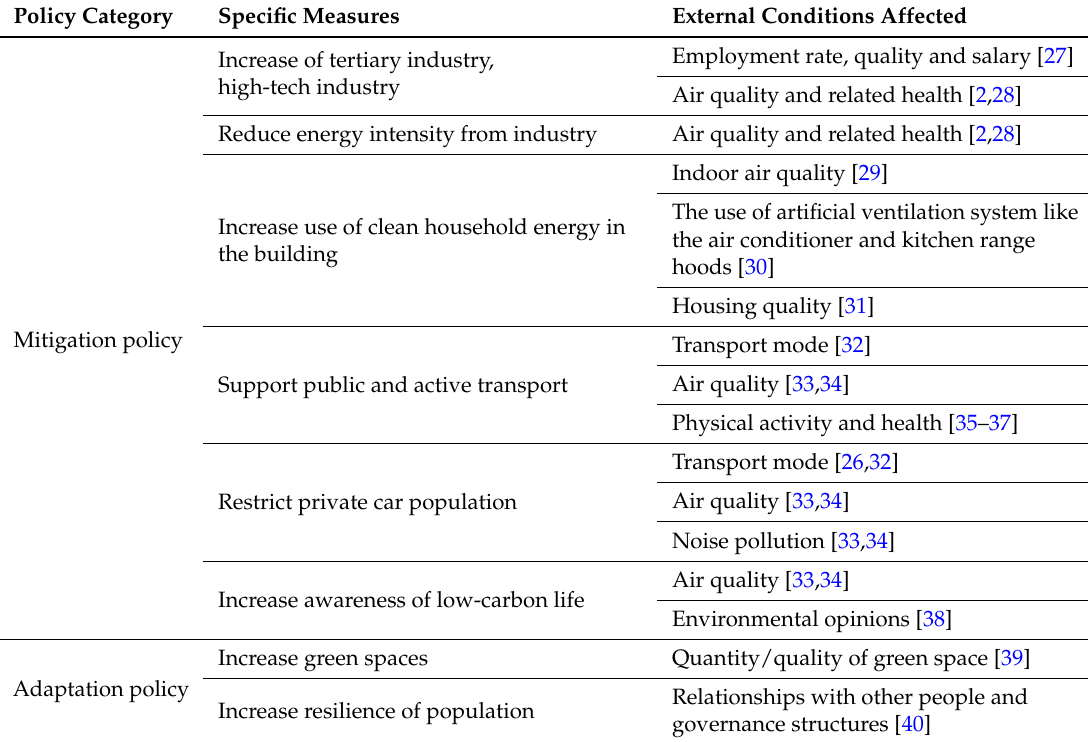
Table 1. The list of climate change mitigation and adaptation policies in